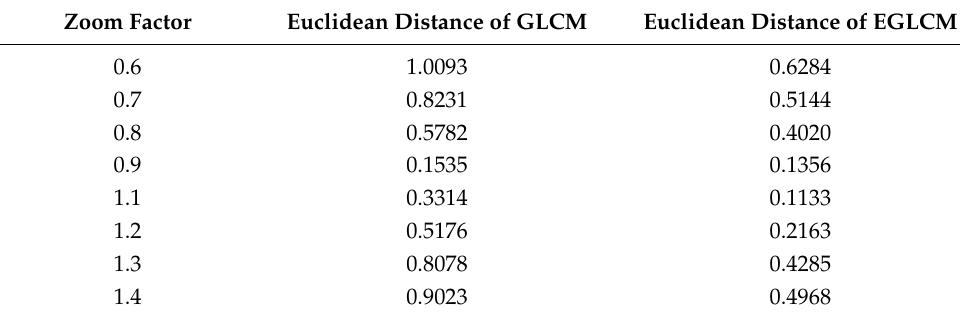
Table 12. Euclidean distances of GLCM and EGLCM with different zoom